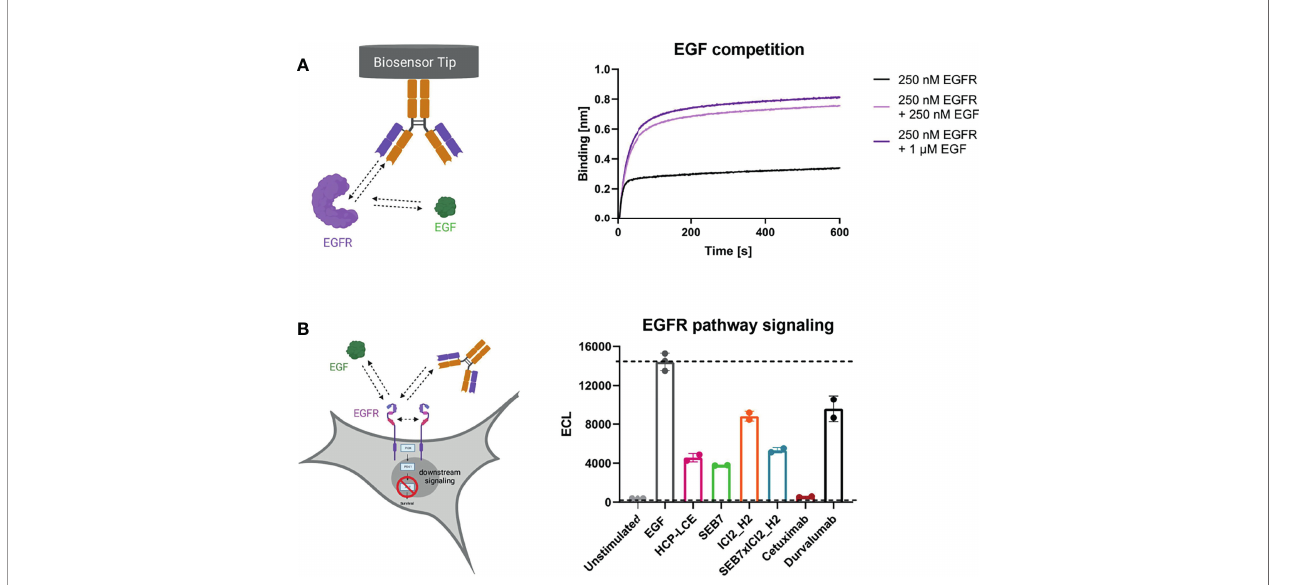
FIGURE 4 | EGF competition and EGFR signaling assays. (A) BLI-assisted EGF competition assay. HCP-LCE was loaded onto AHC biosensors and subsequently associated to EGFR pre ‐ incubated with varying EGF concentrations. HCP-LCE binds to EGFR despite EGF binding. (B) Cell-based EGFR signaling assay. EGF- induced AKT phosphorylation was analysed in EGFR-positive A549 cells. SEB7 (green), ICI2_H2 (orange), the bispeci fi c construct SEB7xICI2_H2 (blue), cetuximab (red) and durvalumab (black) were tested in comparison to the Two-in-One antibody HCP-LCE (pink). All measurements were performed in triplicates. Created with BioRender.com.